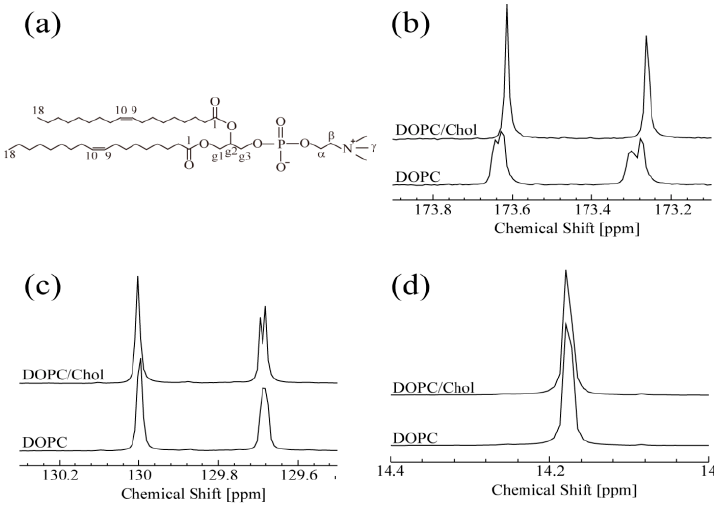
Figure 1. ( a ) Systematic numbering of the chemical structure DOPC. ( b – d ) 13 C-NMR spectra of DOPC and DOPC/Chol systems at 15 ◦ C. ( b ) Both peaks correspond to C1 of DOPC. ( c ) Peaks around 129.7 ppm and 130.0 ppm correspond to C10 and C9 of DOPC, respectively. ( d ) Peaks correspond to C18 of